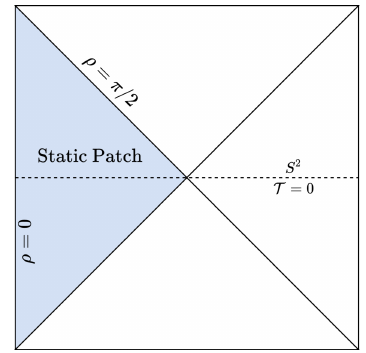
Figure 1 . The Penrose diagram of dS 3 , with the static patch highlighted. Constant time slices are two-spheres, with the T = 0 shown explicitly, and the left and right-hand sides of the diagram are the poles of S 2